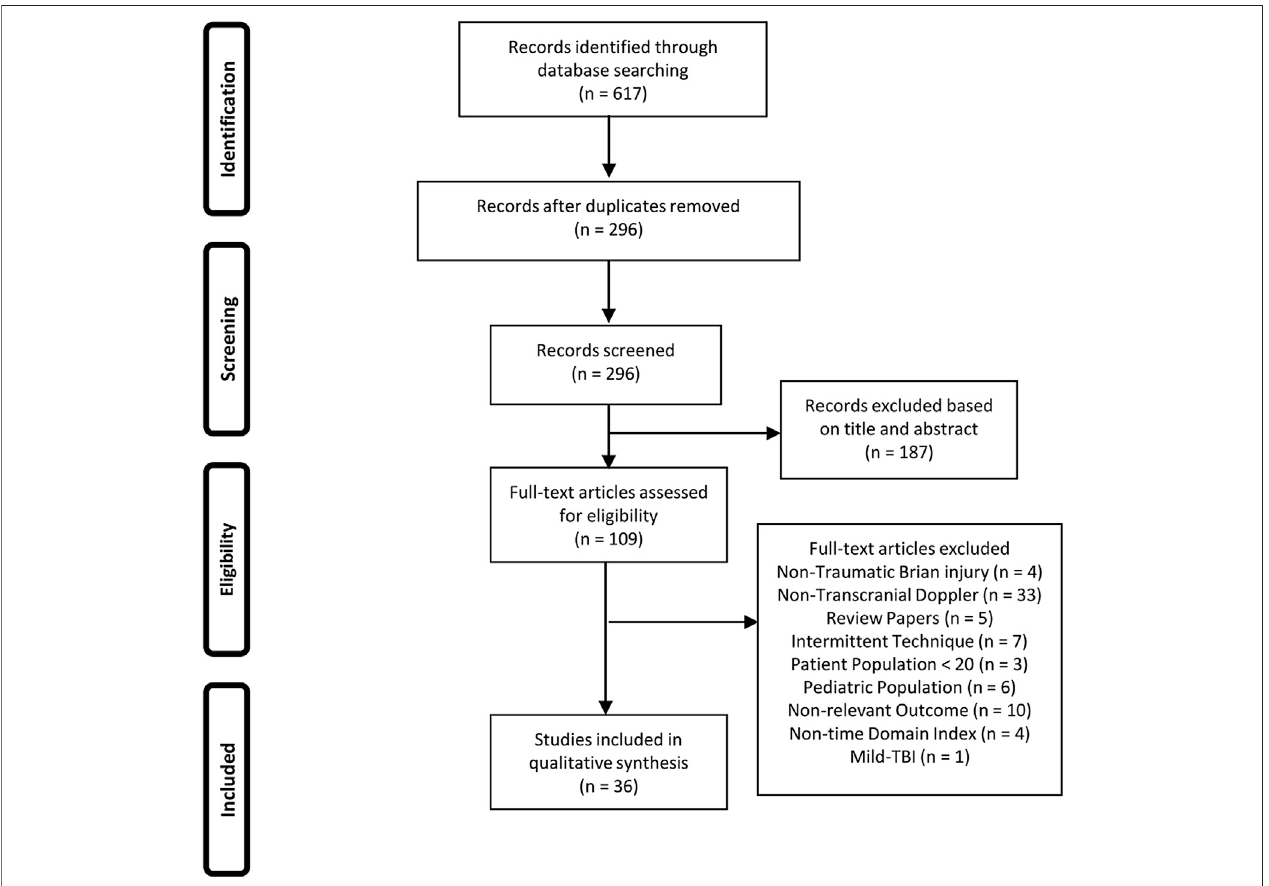
FIGURE 1 | A PRISMA flow-diagram of the systematically conducted scoping review of the literature.